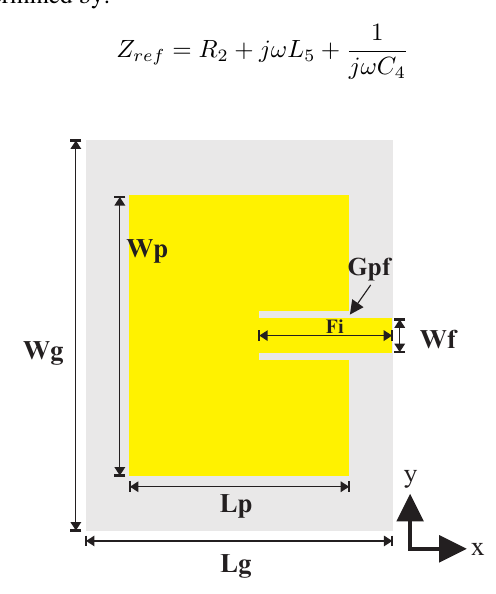
FIGURE 1. Top view of the HGWMPA.